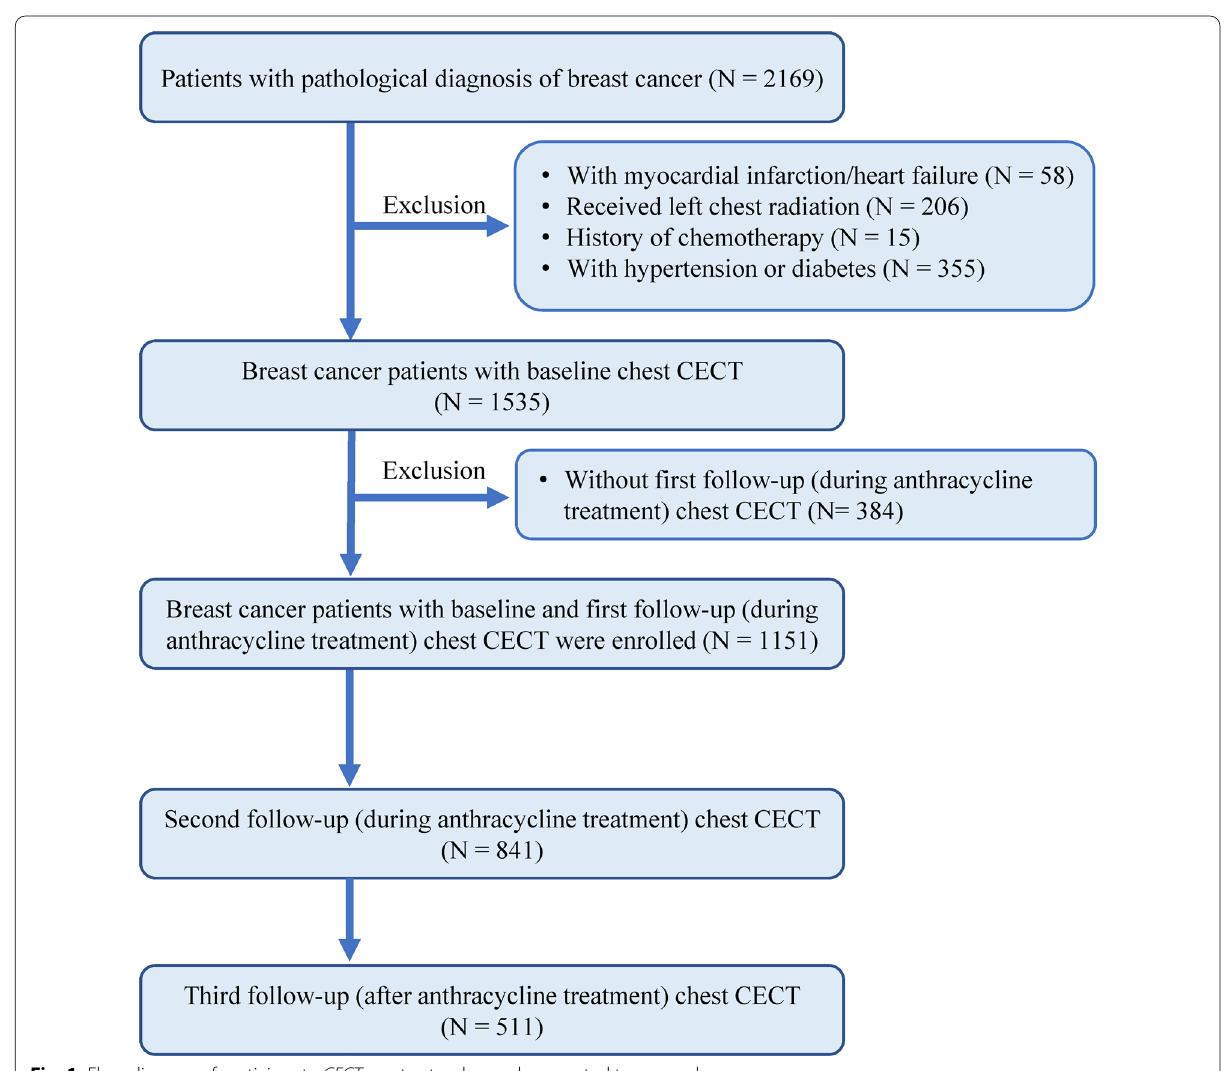
Fig. 1 Flow diagram of participants. CECT , contrast-enhanced computed